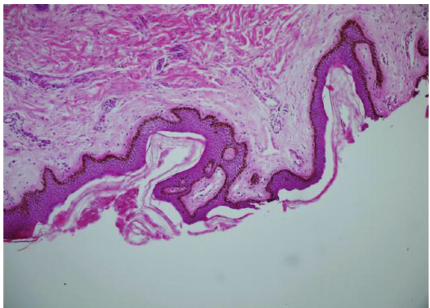
Figure 4: Hyperkeratosis, papillomatous mild acanthosis in the epidermis and hyperpigmentation at the basal layer (H& E, x20